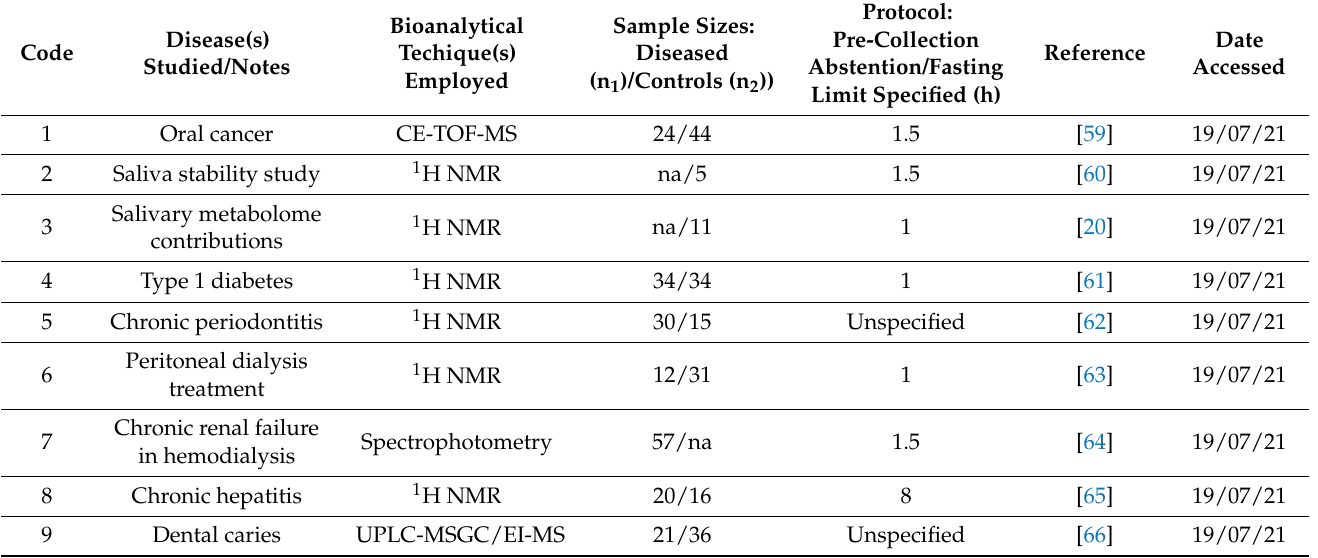
Table 2. Systematic review of pre-abstention/fasting time limits for metabolomics